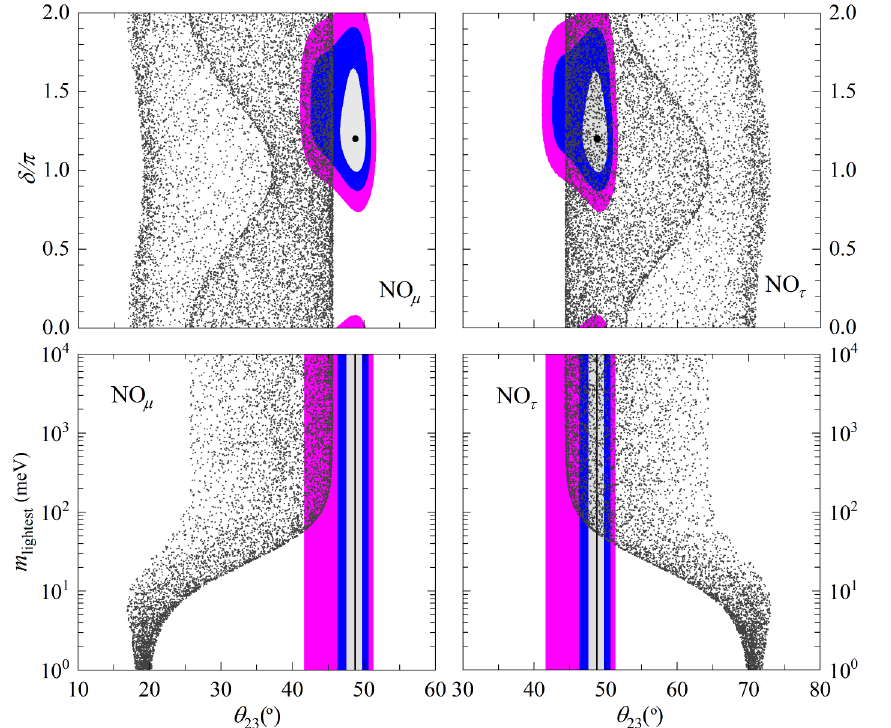
Figure 4 . Model preference for the first (second) θ 23 octant in the NO µ (NO τ ) scenario. The ( θ ) scatter points (upper panels) and ( θ ) (lower panels) obey eq. (2.18) . The 1 σ , 2 σ 23 , δ 23 , m lightest and 3 σ regions are shown in gray, blue and magenta, respectively. The black dot and vertical line correspond to the best-fit. The overlap between the scatter plots and the experimentally-allowed regions produce the results of figure